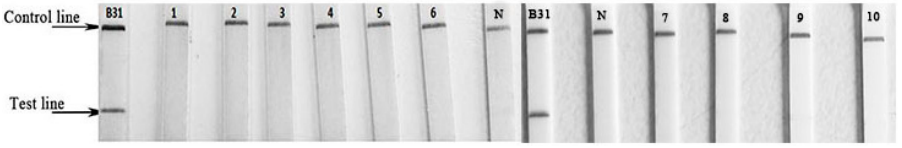
Figure 3. Result of LF-RPA assay in non- Borrelia strain detection. B31: positive control; 1, Ehrlichiae ; 2, Bartonella henselae ; 3, Anaplasma phagocytophilum ; 4, Coxiella burnetii ; 5, Leptospira 56603; 6, Escherichia coli BL21; 7, Leptospira 56602; 8, Leptospira 56601; 9, Leptospira 56613; 10, healthy blood DNA; N, negative control (water). Table 1. Results of 20 Lyme borreliosis (LB) patients’ samples detected by real-time qPCR, nested-PCR and recombinase polymerase amplification with lateral flow